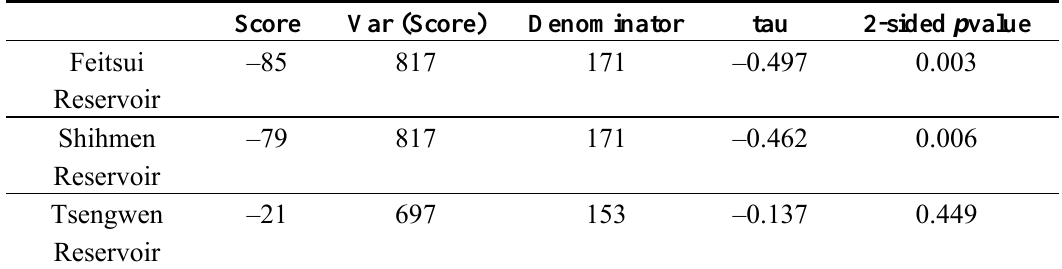
Table 3. Trend of water quality of TP.